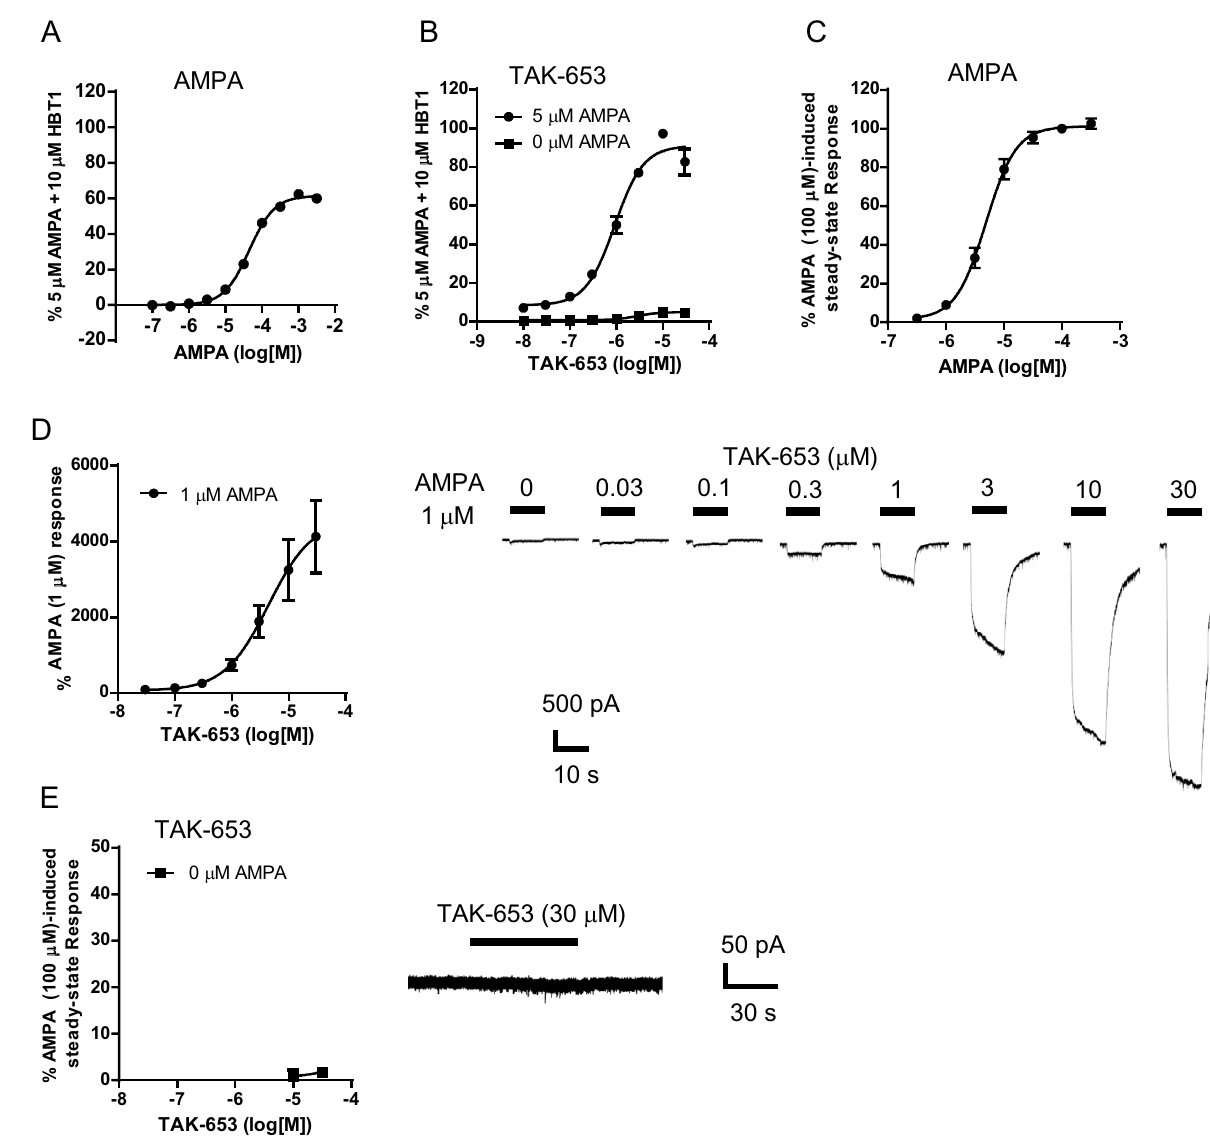
Figure 2. Effect of TAK-653 on Ca 2+ influx and AMPA-R currents in rat primary hippocampal neurons. ( A ) Effect of AMPA on Ca 2+ influx in primary hippocampal neurons. ( B ) Effect of TAK-653 on Ca 2+ influx in primary hippocampal neurons. TAK-653 was applied in the presence or absence of 5 μM AMPA. Data are represented as mean ± SD (n = 3). ( C ) Effects of AMPA on AMPA-R-mediated currents using primary hippocampal neurons. ( D , E ) Effects of TAK-653 on AMPA-R-mediated currents using primary hippocampal neurons. The responses to TAK-653 were measured in the presence ( D ) or absence ( E ) of 1 μM AMPA. AMPA-R potentiator was applied 20 s prior to 10-s AMPA stimulus. Without AMPA, the maximum current was measured during 60-s application. Data are represented as mean ± SEM (n =